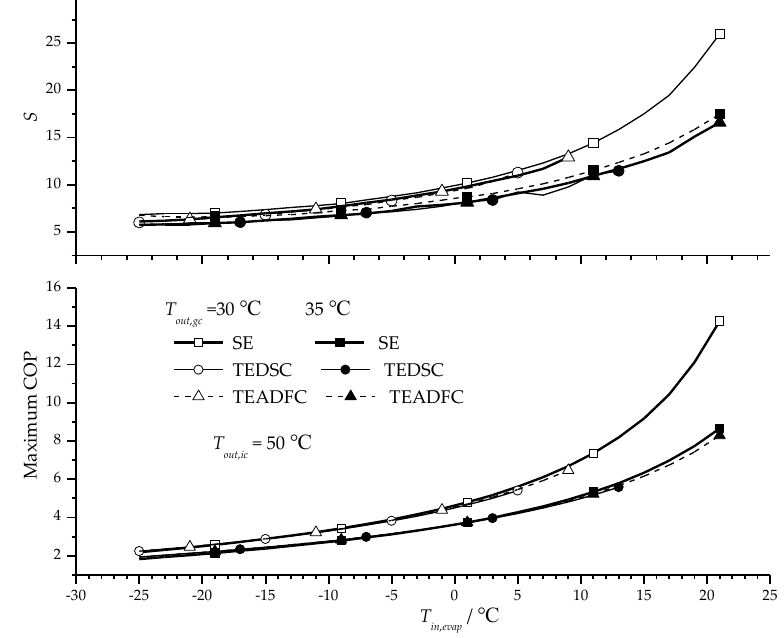
Figure 5. Sensitivity of maximum COP to temperature at the evaporator inlet.